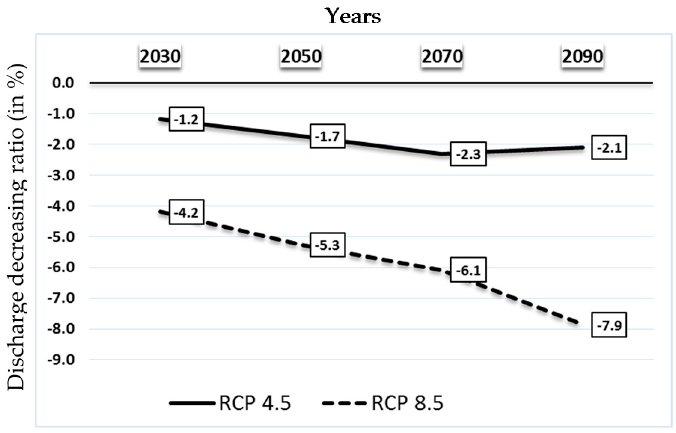
Figure 7. Future variations in the Sassandra natural river discharge when compared to the baseline per climate scenarios (RCPs 4.5 and 8.5).